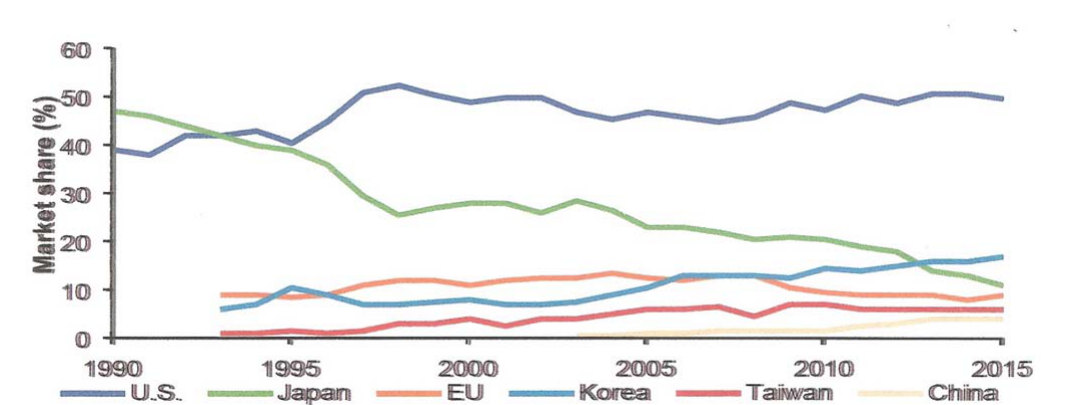
Figure 1. Relative semiconductor device market share based on company HQ (Source: Semiconductor Industry Association SIA,